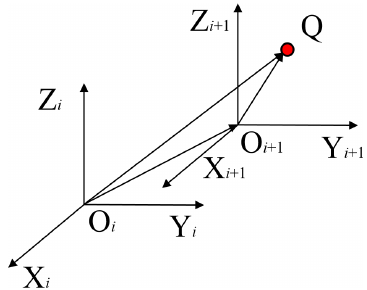
Figure 7. Homogeneous transformation.